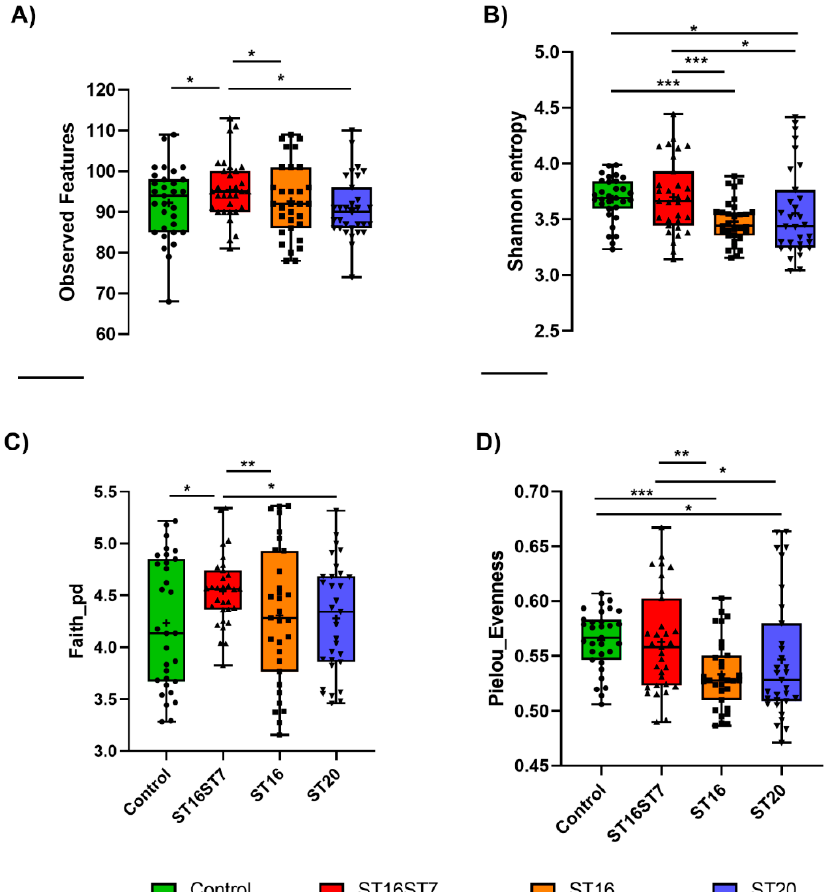
Figure 2. Observed features ( A ), Shannon indices ( B ), Faith’s_PD ( C ), and Pielou’s evenness ( D ) estimates of the identified microbiota in each sample, from bioreactors with either a no-treatment control, or treated with ST16- S. thermophilus , a combination of ST7- L. bulgaricus and ST16- S. thermophilus, or ST20- B. animalis . Data were analyzed using the Kruskal–Wallis test and a ywo-stage Benjamini,